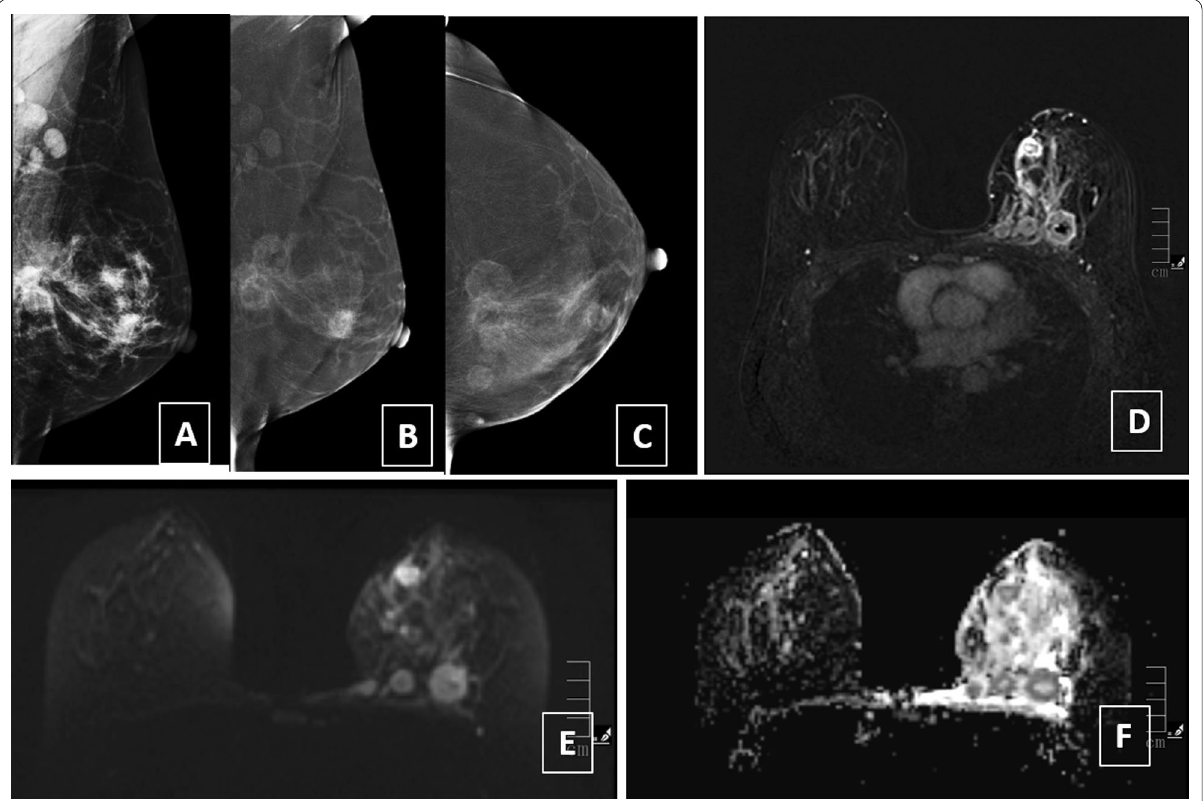
Fig. 1 A 42-year-old female with multifocal left breast ca A MLO low-energy CESM ( B ), ( C ) recombined CESM MLO and CC showing multiple enhancing masses lower inner quadrant D DCE-MRI shows marginal enhancement with central necrosis E and F DWI b value respectively, showing peripheral diffusion restriction. ADC value